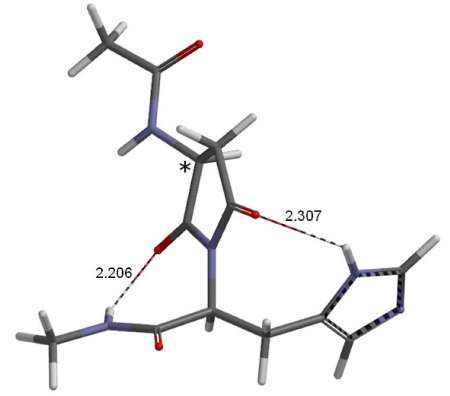
Figure 9. The optimized geometry of the SI product P ( ϕ N = ´ 172 ˝ , ψ N = ´ 145 ˝ , χ 1N = 140 ˝ , ˝ , ψ ˝ , χ ˝ ). The imidazole ring is in a neutral form. Hydrogen bond distances ϕ H = ´ 90 H = 71 1H = ´ 53 are shown in Å. The asterisked carbon corresponds to the Asn α carbon in the reactant